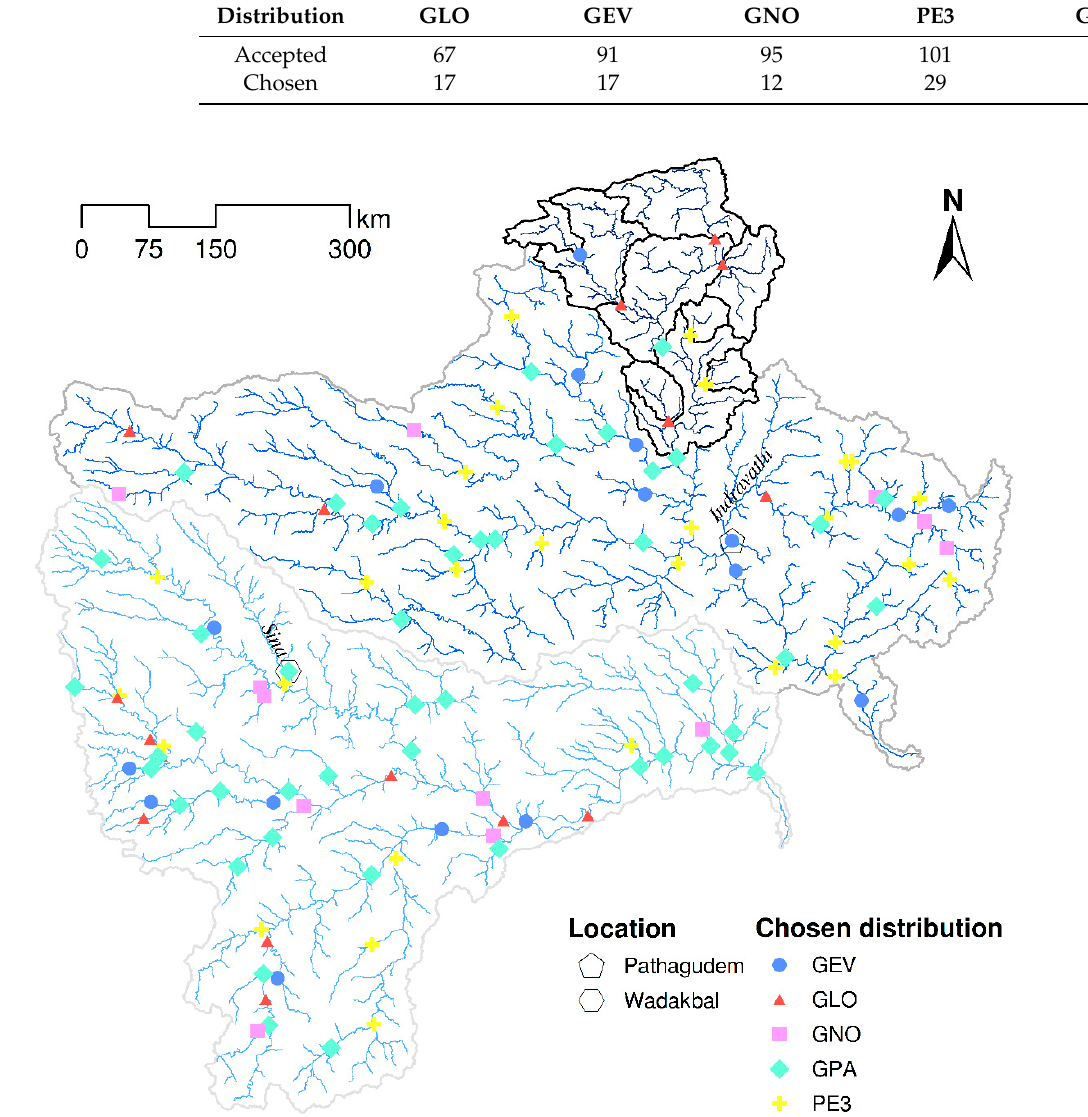
Table 2. Number of stations at which each distribution is acceptable (| Z DIST | < 1.64) and chosen (| Z DIST | = min(|Z DIST |)) to describe the annual maximum (AMAX) series. Distribution